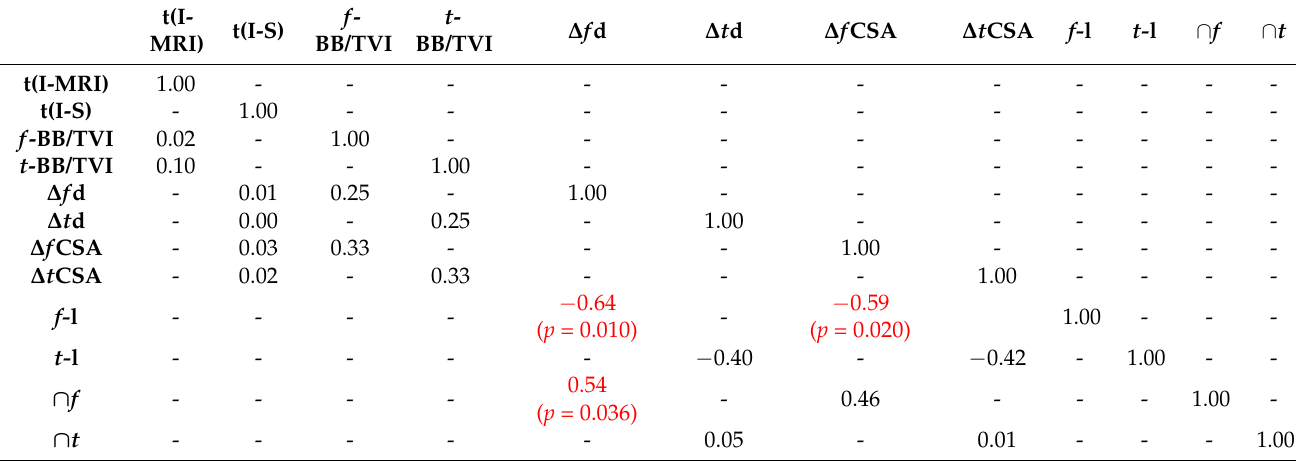
Table 2. Results of correlation analysis for the STGR group. Correlation coefficients are statistically significant at p < 0.05 (in red). t(I-MRI)— time between injury and the MRI scan; t(I-S)—time between injury and surgery; f -BB/TVI (%): volume of BBs in a defined volume of the femur, t -BB/TVI (%): volume of BBs in a defined volume of the tibia, ∆ f d (%): magnitude of change in the bone tunnel diameter in the femur, ∆ t d (%): magnitude of change in the bone tunnel diameter in the tibia, ∆ fCSA (%): magnitude of change in bone tunnel area in the femur, ∆ t CSA (%): magnitude of change in the bone tunnel area in the tibia, f- l (mm): distance between the center of mass of the femoral bone tunnel and center of mass of the BB, t- l (mm): distance between the center of mass of the tibial bone tunnel and the center of mass of the BB, ∩ f (mm 3 ): intersection of the femoral bone tunnel and BB, and ∩ t (mm 3 ): intersection of the tibial bone tunnel and